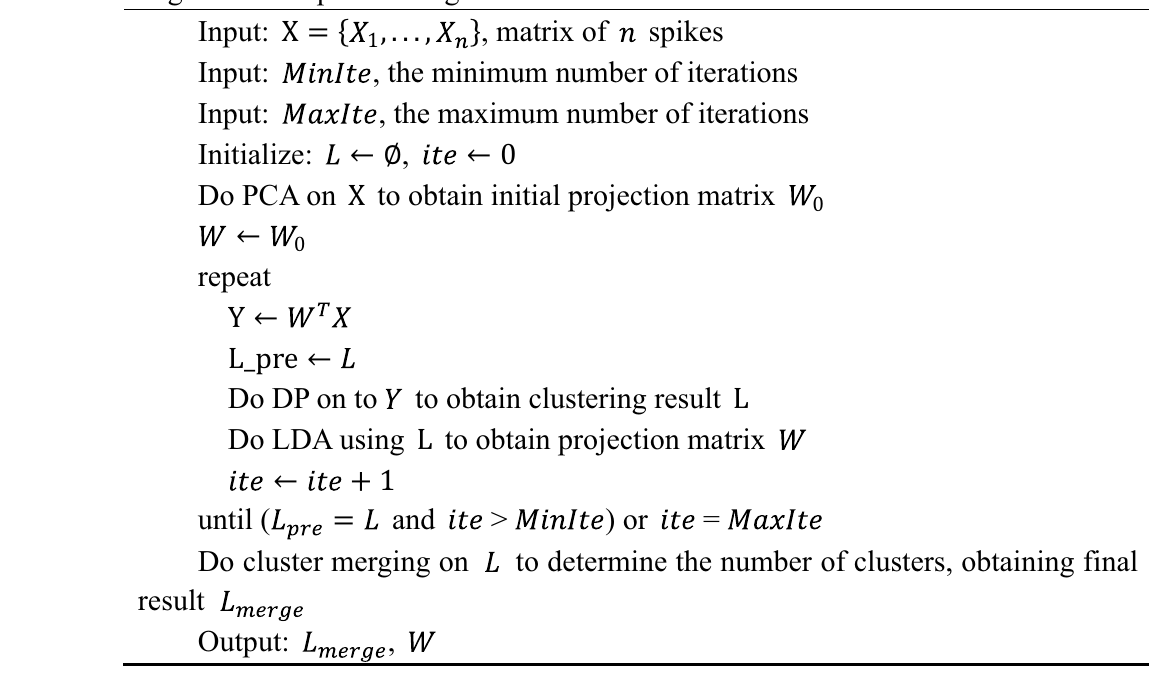
Algorithm 1. Spike sorting based on